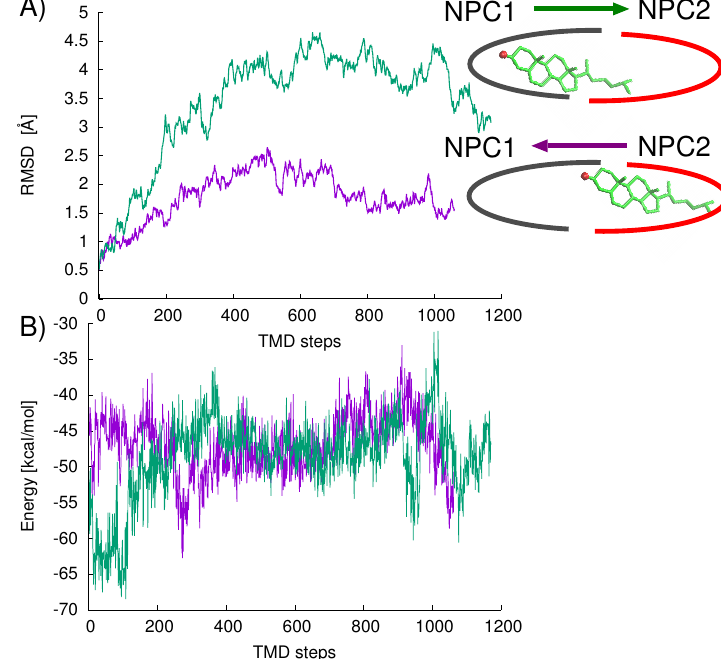
Figure 8. TMD results of cholesterol transfer based on the California model in the direction NPC2 → NPC1 (purple line) shows: ( A ) overall lower protein backbone RMS differences (Å) compared to the opposite direction, NPC1 → NPC2 (green line); ( B ) cholesterol–protein potential energies associated with each TMD path are plotted for both transfer